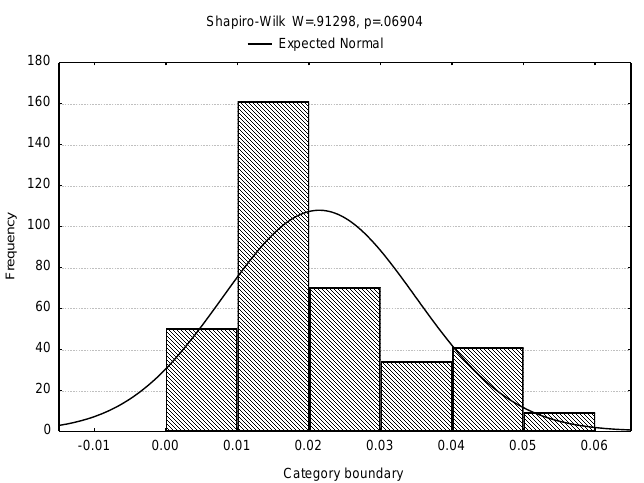
Figure 3. Distribution diagram of the errors in the modeling of the metribuzin concentration in soddy–podzolic soil.